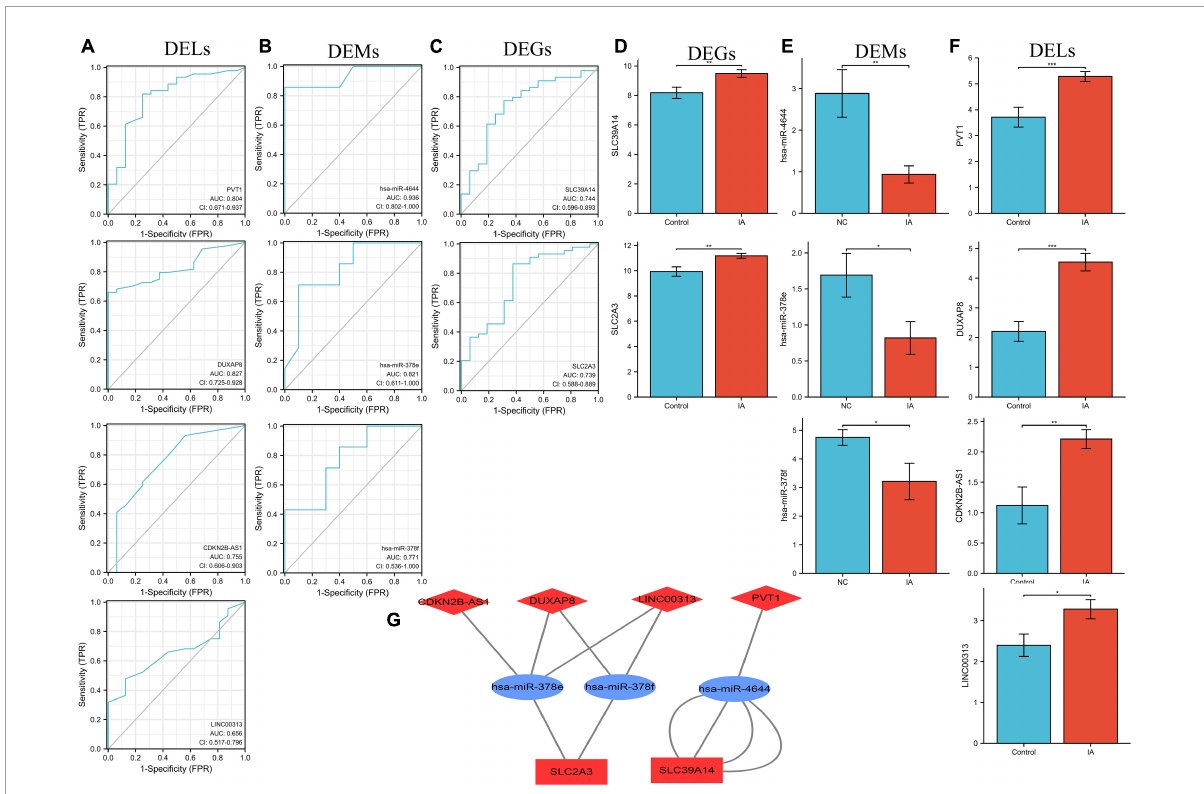
FIGURE5 Construction of the key triple regulatory network. ROC analysis of DELs (A) , DEMs (B) , and DEGs (C) . The expression levels of DEGs (D) , DEMs (E) , and DELs (F) . (G) The key triple regulatory network components identified by regulation of their expression. MiRNAs are represented by ellipses, mRNAs by rectangles, and lncRNAs by diamonds. Navy-blue signifies downregulation and red upregulation.